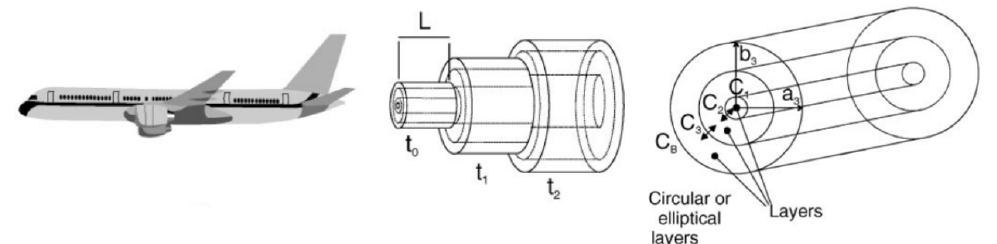
Figure 4. MP model visual representation. Plume length L was set to the distance travelled in 1 s (247 m in this scenario) with three out of eight concentric rings shown for each timestep. C 1 − C 3 indi- cate the concentrations in each ring, with arrows representing mixing between the layers. Reprinted with permission from Kraabøl et al. [2]. Copyright 2022, Pergamon.